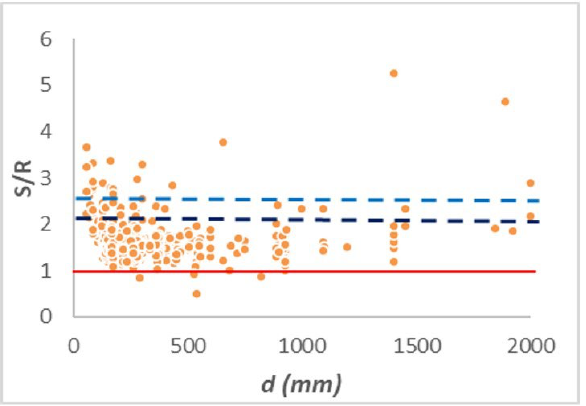
to Frosch et al. 𝑑𝑑